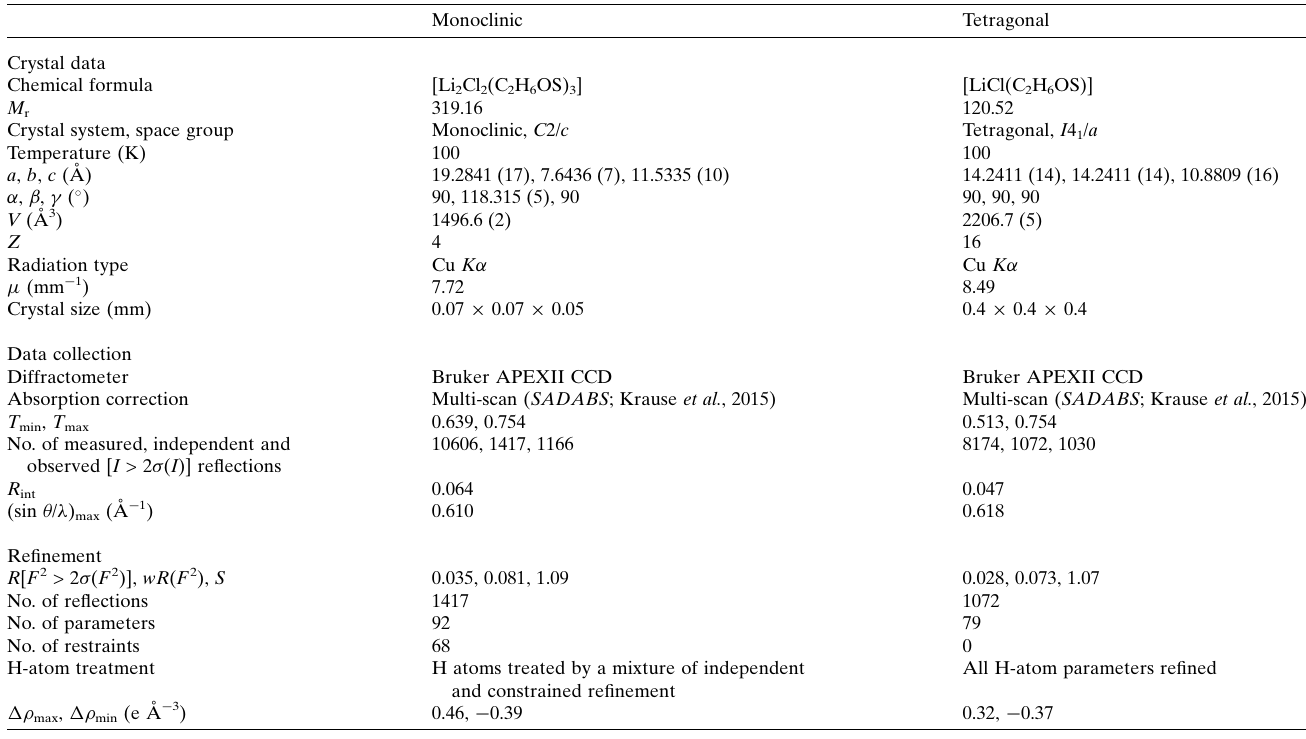
Table 3 Experimental details.